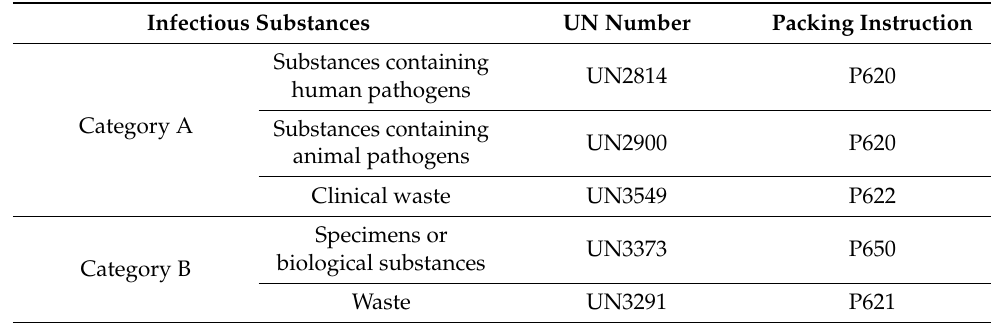
Table 1. Infectious substances classification and packing instructions according to the ADR